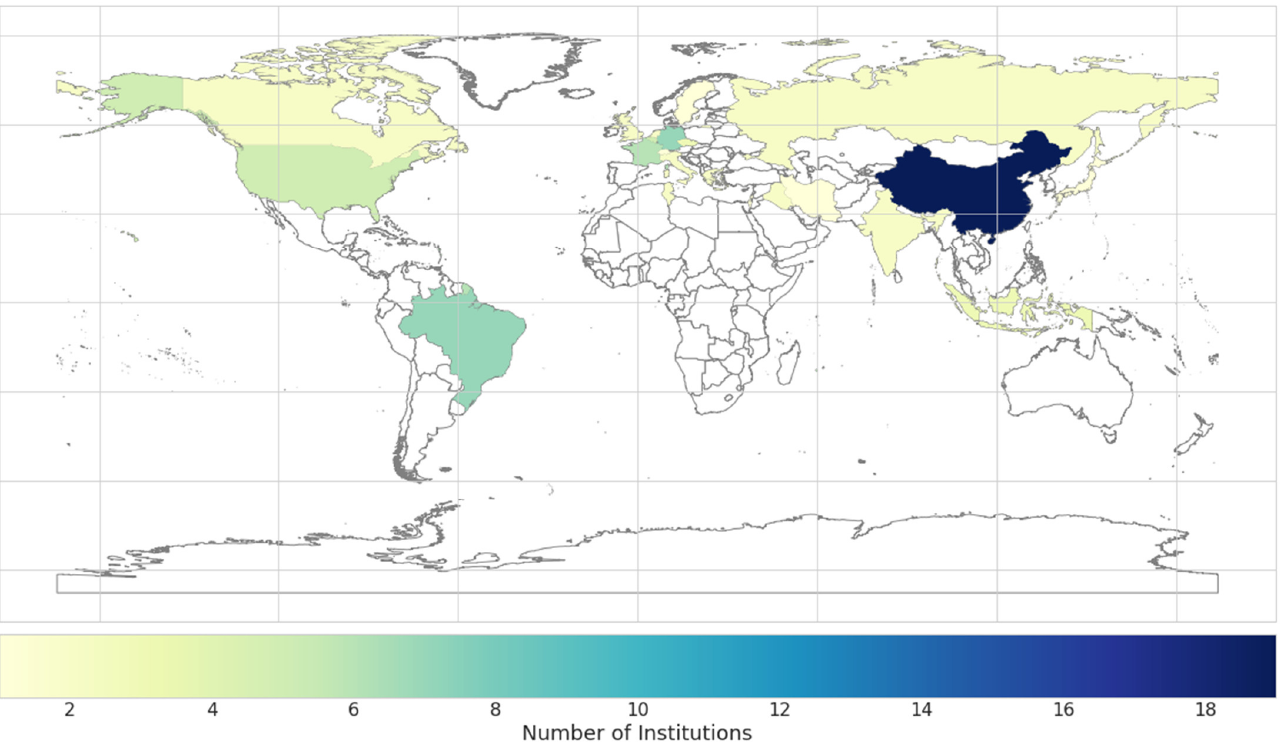
Figure 8. Total number of institutions per country that contributed to research studies included in this review. Outlined countries have zero occurrences.